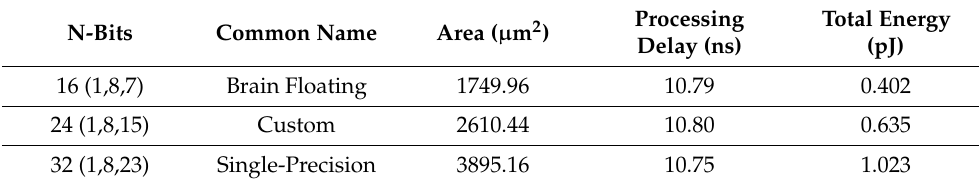
Table 4. Comparison of N-bit floating-point